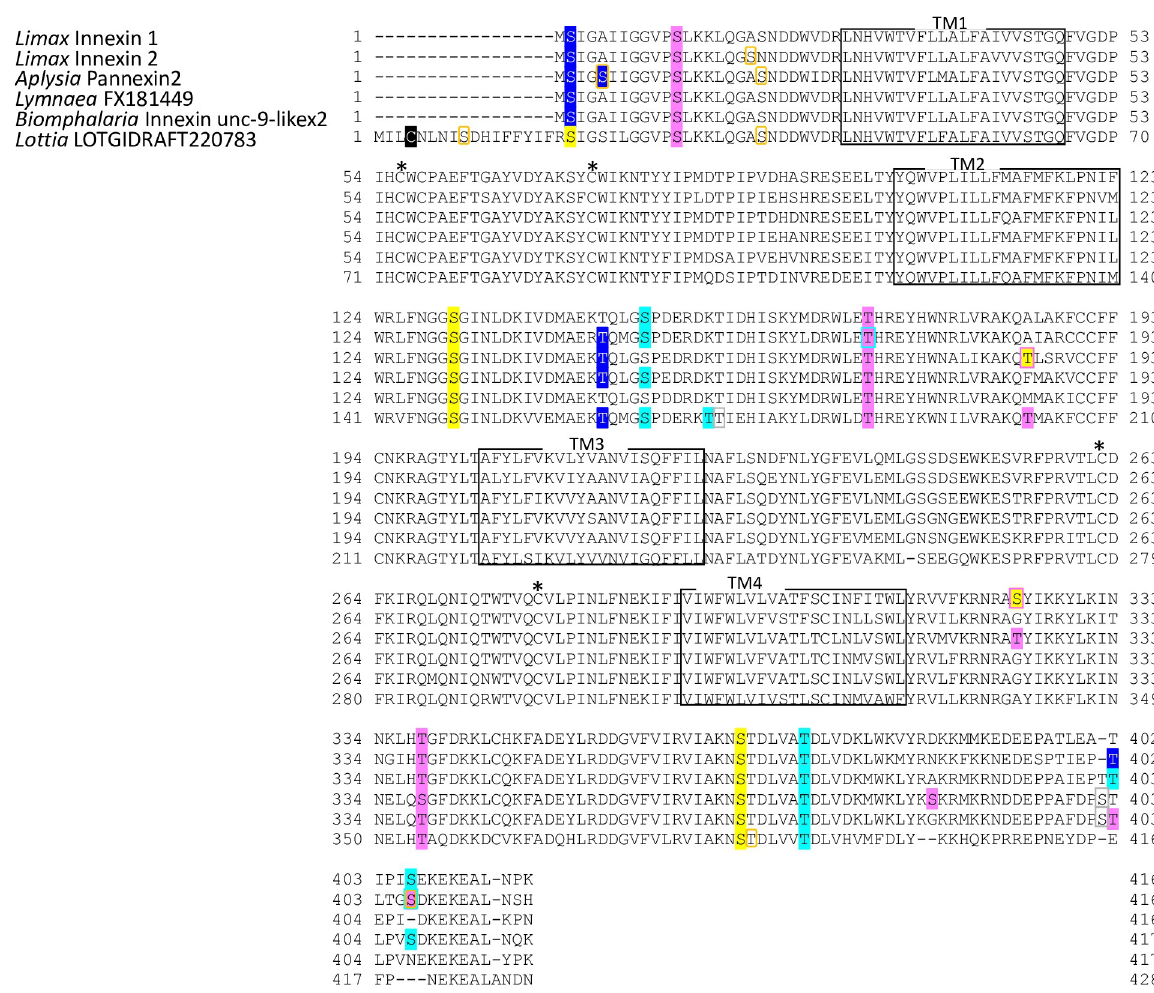
Fig 3. Protein sequence alignment of molluscan innexin orthologs in Group 1. Alignment of deduced amino acid sequences of Limax innexin 1 and 2 with orthologous innexin sequences. The boxes show the four transmembrane domains, while the asterisks indicate the extracellular cysteine residues. The potential S-nitrosylation sites are shaded in black. The phosphorylation sites are indicated with shading or box in magenta (protein kinase C), yellow (protein kinase A), blue (casein kinase 1), cyan (casein kinase 2), orange (P34cdc), and gray (protein kinase G).